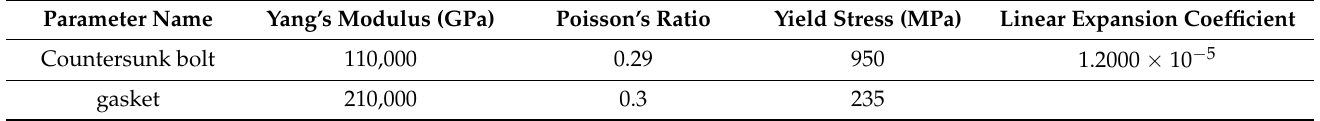
Table 1. Material properties of countersunk head bolts (Unit: